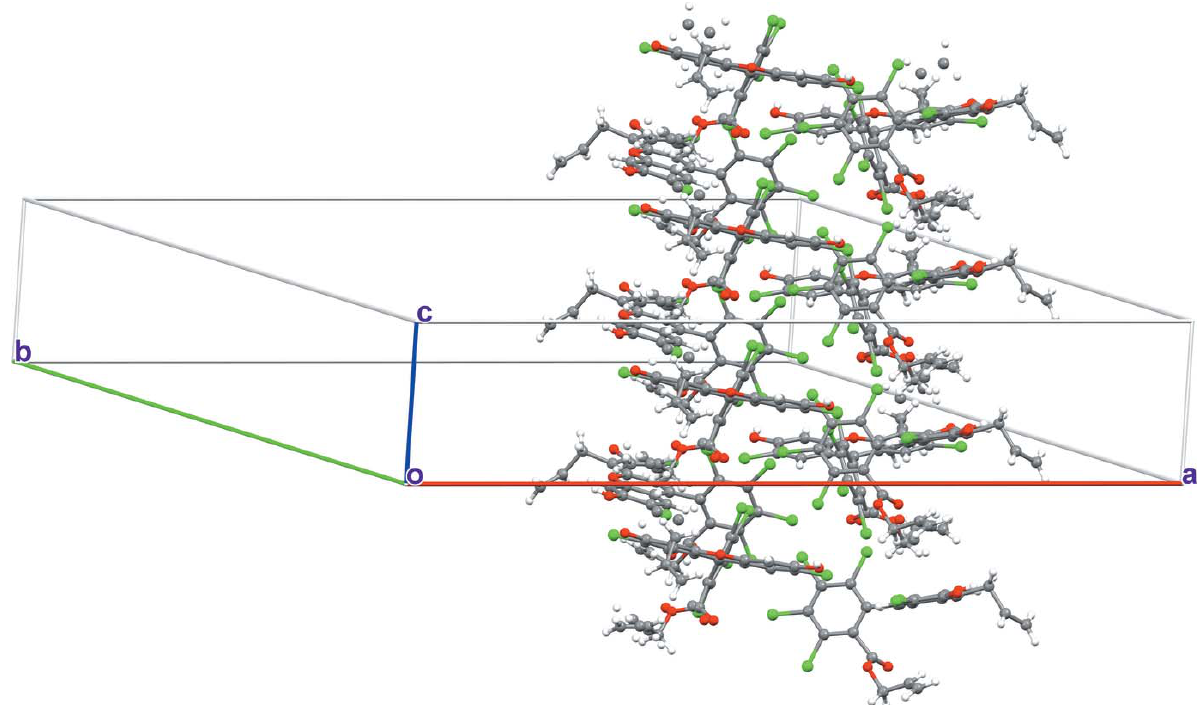
Figure 4 Three-dimensional packing diagram of the title